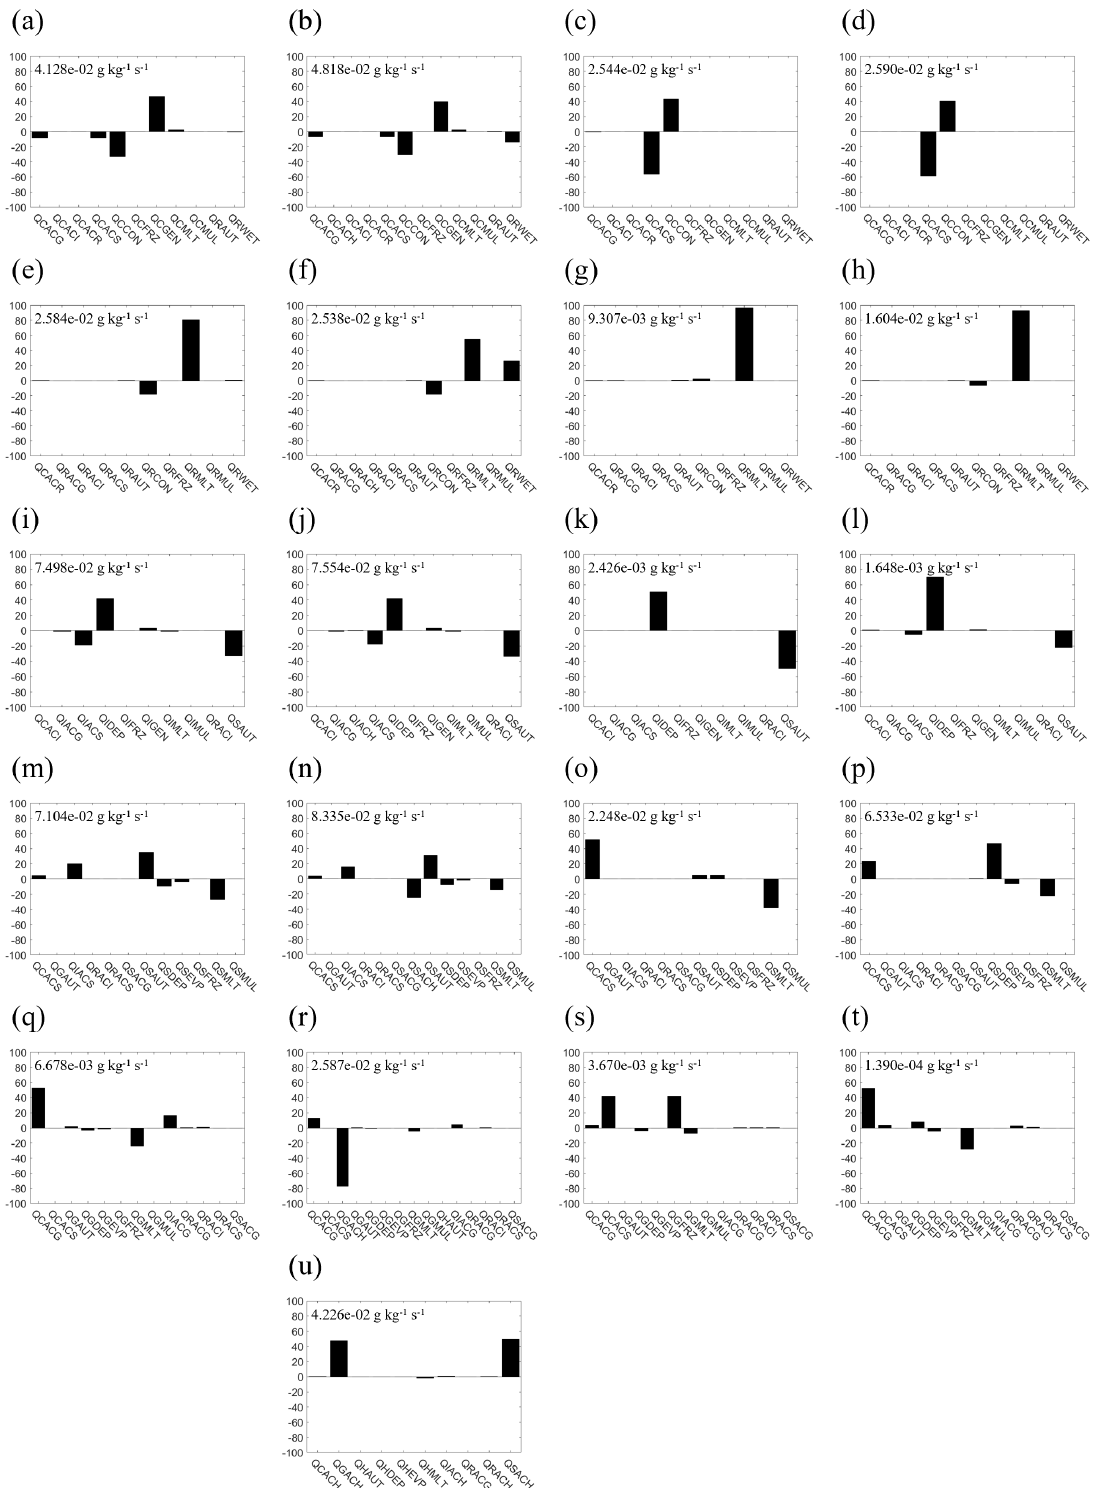
Figure 9. Relative contribution of time-domain-averaged production tendency term during the analysis period. From left to right, columns indicate the simulation results with the WDM6, WDM7, Thompson, and Morrison schemes, respectively. Panels (a)–(d) are the terms for cloud water, panels (e)–(h) are the terms for rain, panels (i)–(l) are the terms for cloud ice, panels (m)–(p) are the terms for snow, panels (q)–(t) are the terms for graupel, and panel (u) is the terms for hail. The hail is only predicted in WDM7. In the upper-left corner of each panel, the sum of the absolute values of each production trend corresponding to 100% is noted as the scaling